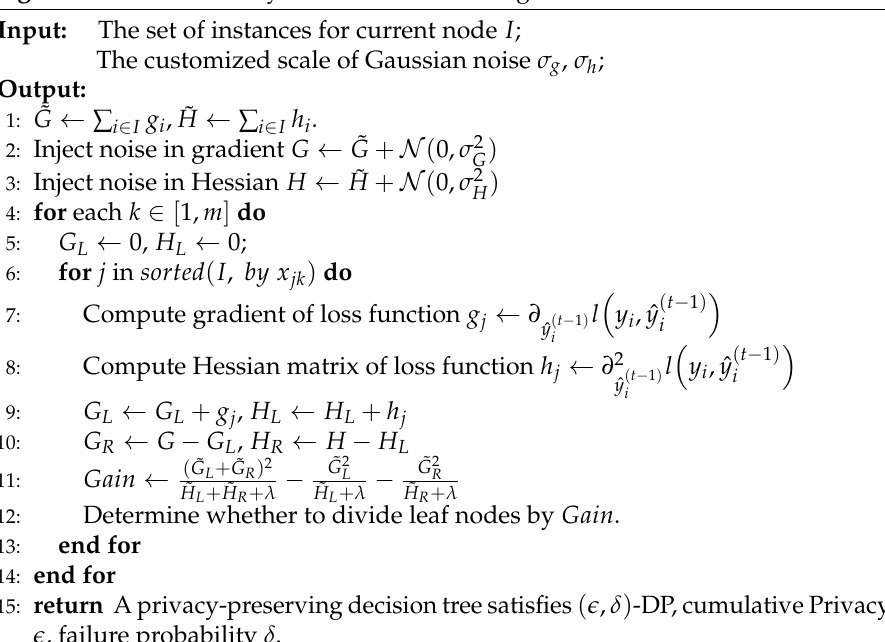
Algorithm 1 Differentially Privated XGBoost